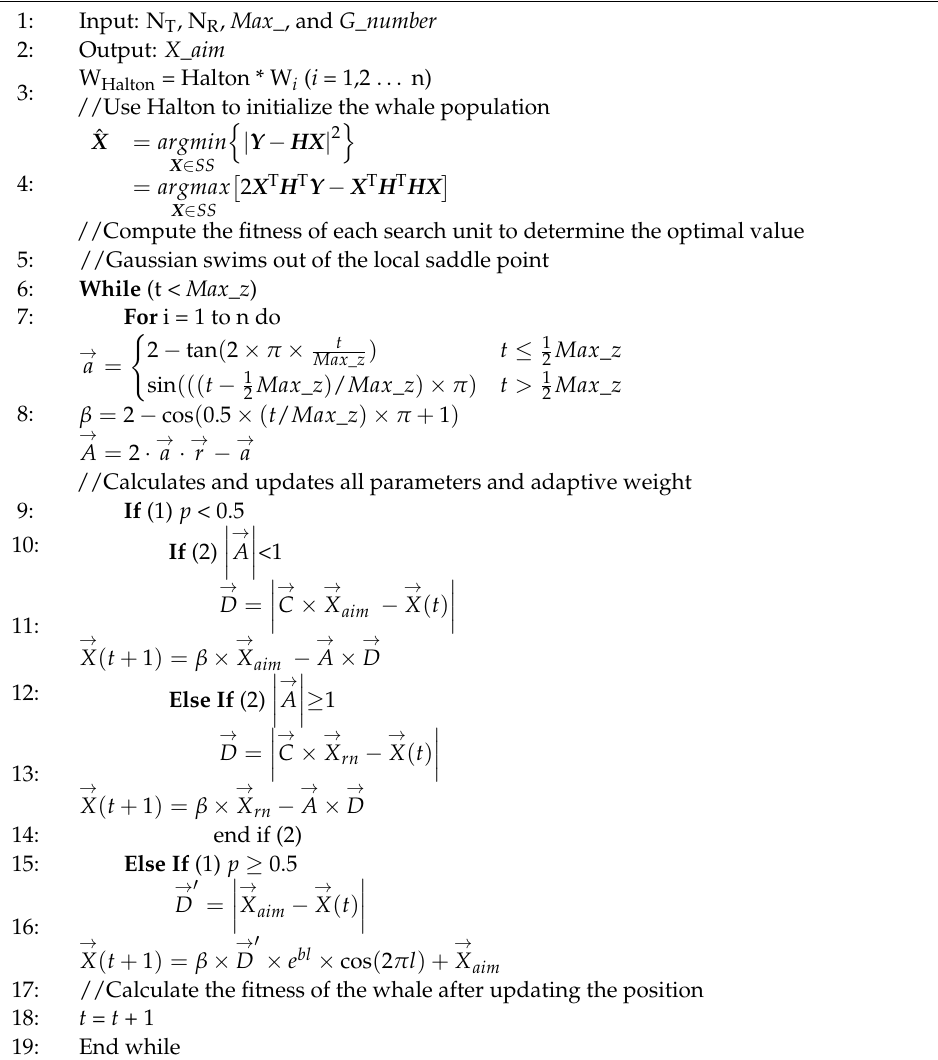
Algorithm 1 : The AWOA for underwater MI-MIMO signal